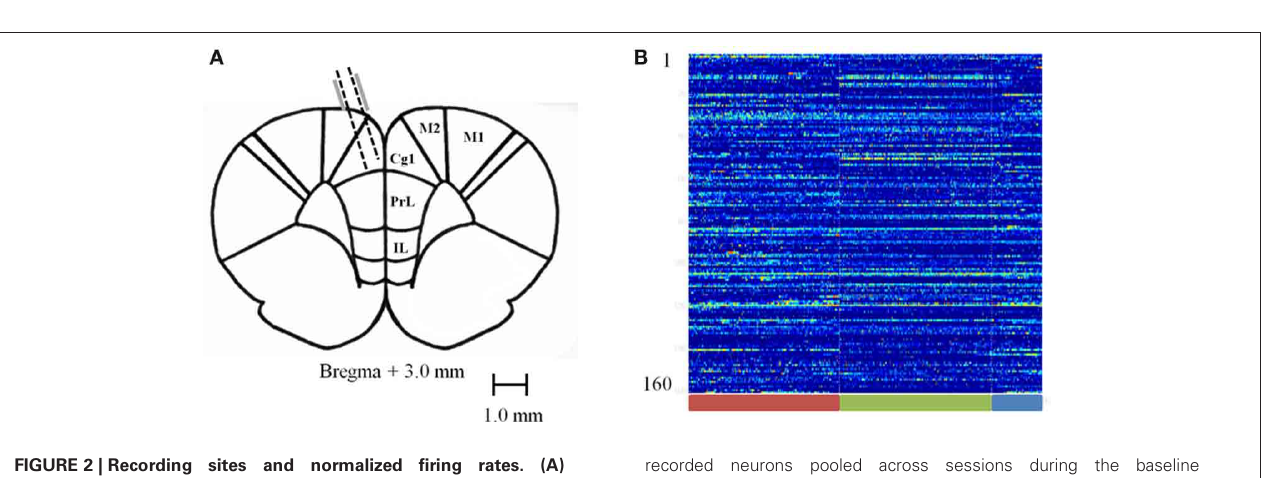
FIGURE 2 | Recording sites and normalized firing rates. (A) Diagram of recording sites. Tetrodes were lowered 1.5–2.5mm at a 15 degree angle into the ACC. (B) Carpet plot of 160